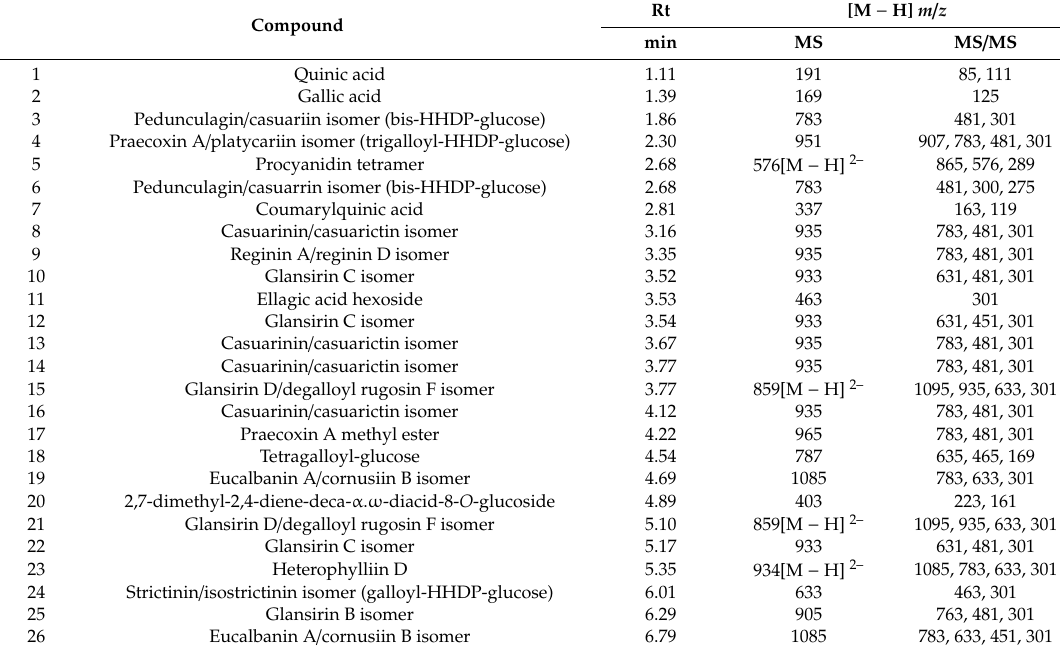
Table 3. Individual phenolic compounds identified by ultraperformance liquid chromatography (UPLC). Compound